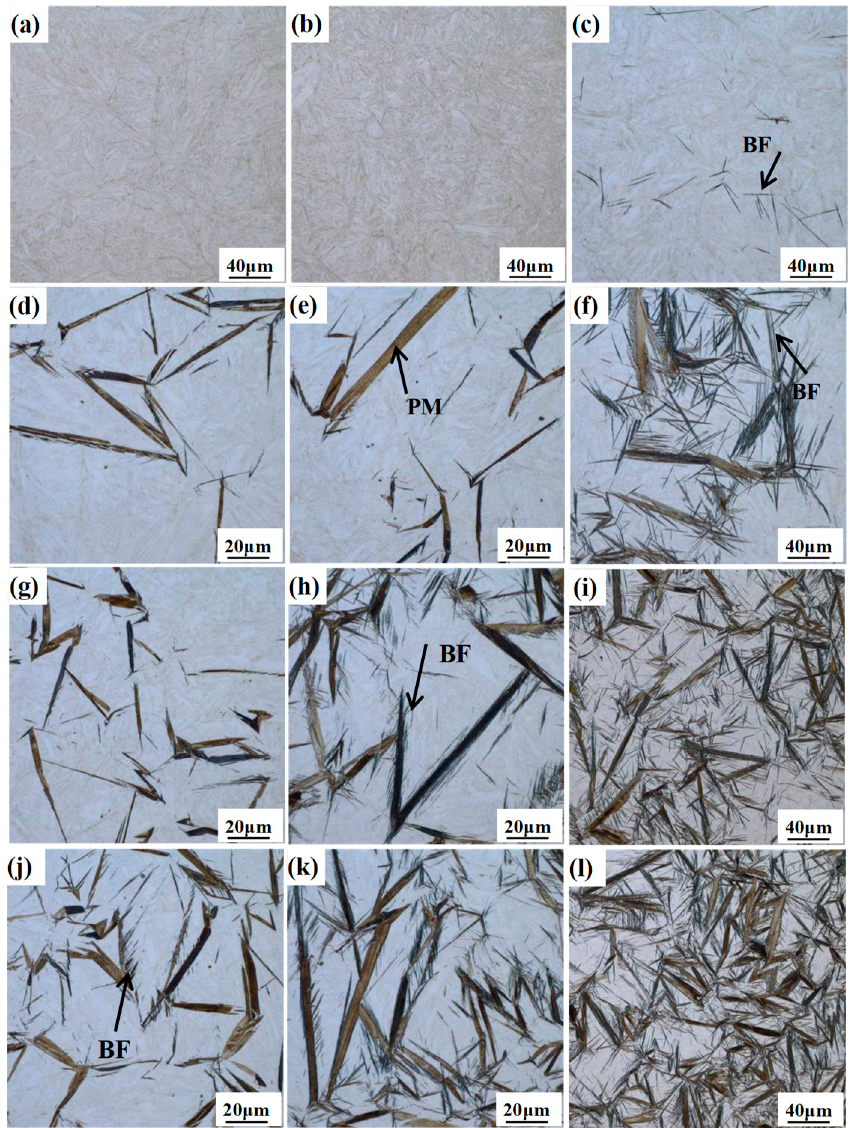
Figure 3. ZEISS AX10 light microscope (LM) micrographs of different samples transformed at 300 °C for different times. ( a – c ) are the DIT sample austempering for 1, 5, and 10 min, respectively; ( d – f ) are the QBT-5 sample austempering for 1, 5, and 10 min, respectively; ( g – i ) are the QBT-7 sample austempering for 1, 5, and 10 min, respectively; ( j – l ) are the QBT-12 sample austempering for 1, 5, and 10 min, respectively. BF refers to bainitic ferrite, and PM refers to prior martensite.